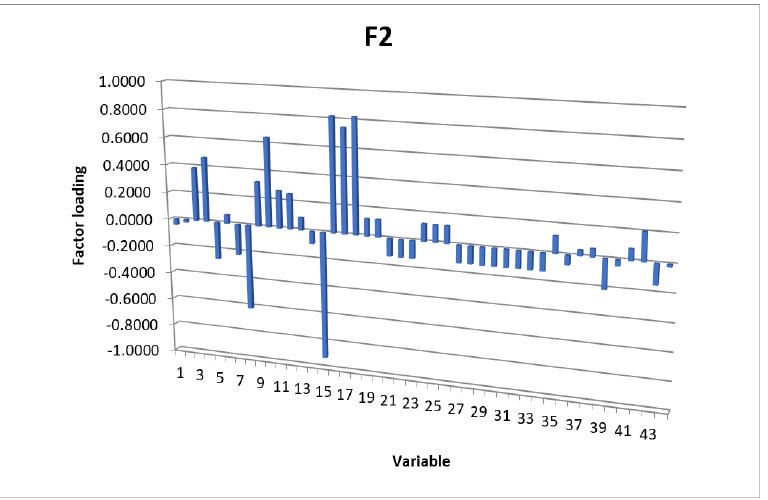
Figure 7. Graphic depiction of factor loads values for input variables for factor F2.